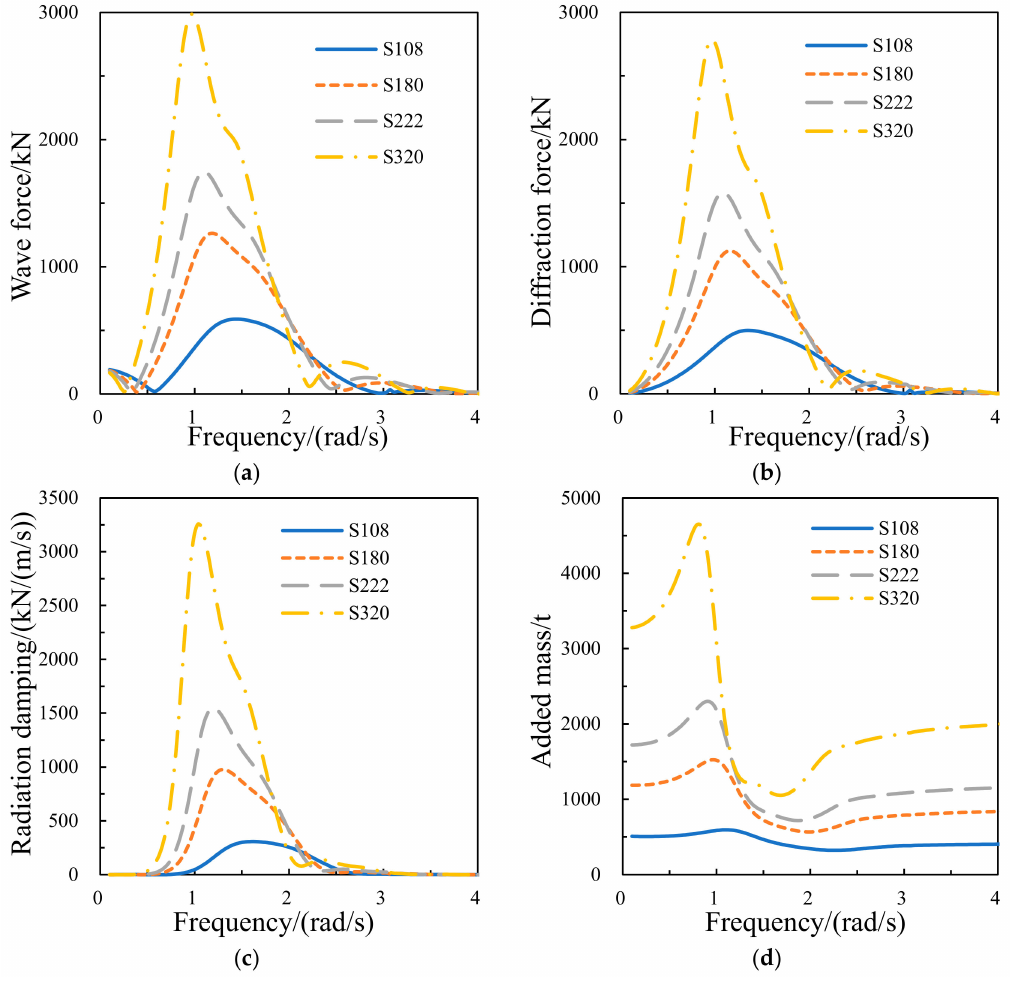
Figure 9. Four hydrodynamic parameter curves. ( a ) Wave force, ( b ) di ff raction force, ( c ) radiation damping, ( d ) added